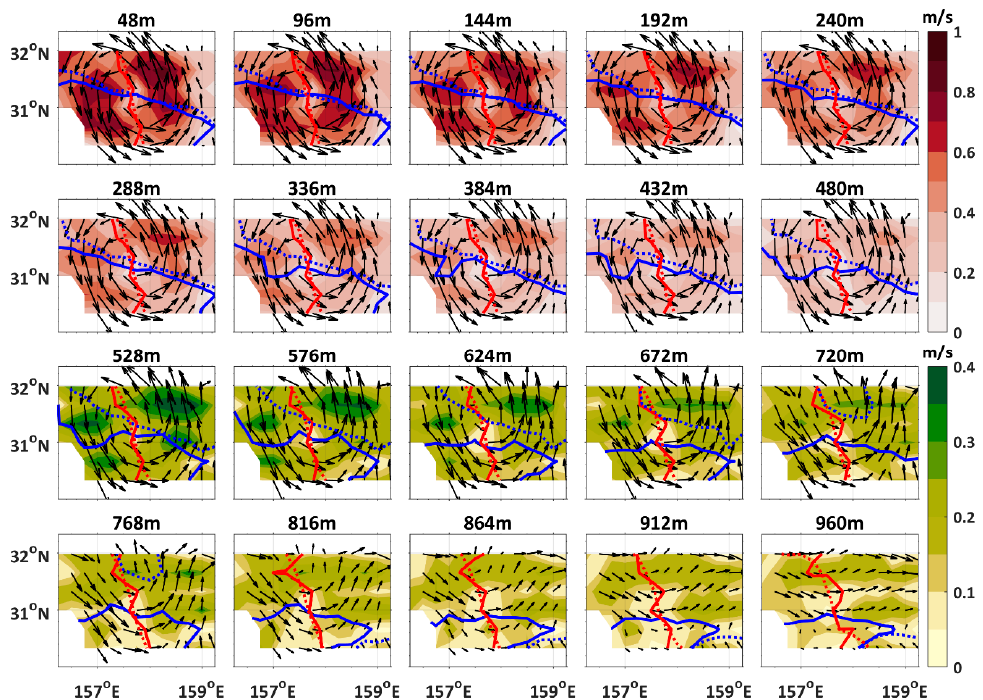
Figure 4. Velocity observed by the 38 kHz shipboard acoustic Doppler current profilers (ADCP) at various depths. Shaded areas show the magnitude of the velocity. Vectors show the flows direction and magnitude. The red and blue full (dotted) lines indicate the zero lines of observed (geostrophic) meridional and zonal velocities, respectively.